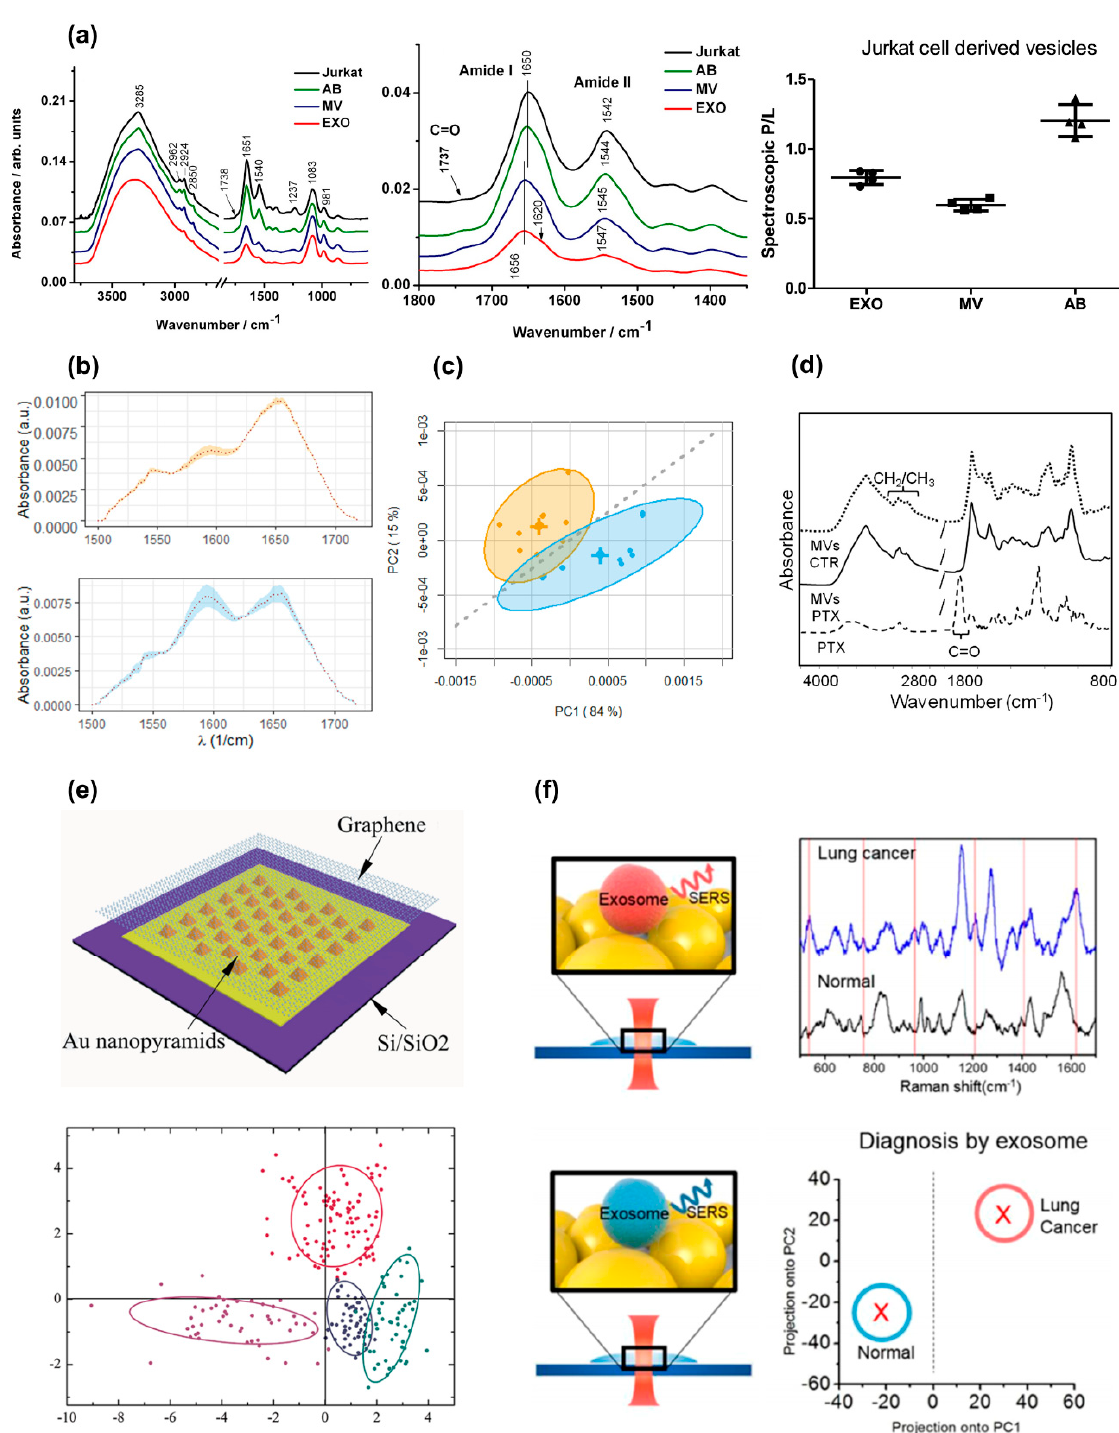
Figure 5. ( a ) Mid-IR characterization of EXOs MVs and Abs extracted from Jurkat T cells in ref [25]. Reprinted with permission from [25]. Copyright (2017) Elsevier. ( b ) Amide I and II bands measured on EXOs extracted from HT29 cancer cell lines well-fed and under serum starvation together with ( c ) the results of a PCA–LDA analysis [139]. ( d ) Mid-IR spectra of PTX-loaded molecules for drug-delivery purposes. Reprinted with permission from [134]. Copyright (2014) Elsevier. ( e ) Plasmonic nanopyramids for SERS of exosomes originating from different cell types together with the results of a PCA-based classification. Reprinted with permission from [141]. Copyright (2019) American Chemical Society. ( f ) SERS characterization of exosomes derived from human lung carcinoma (H1299, H522) and PAEpiC cell lines, with the corresponding PCA. Reprinted with permission from [142]. Copyright (2017) American Chemical Society.